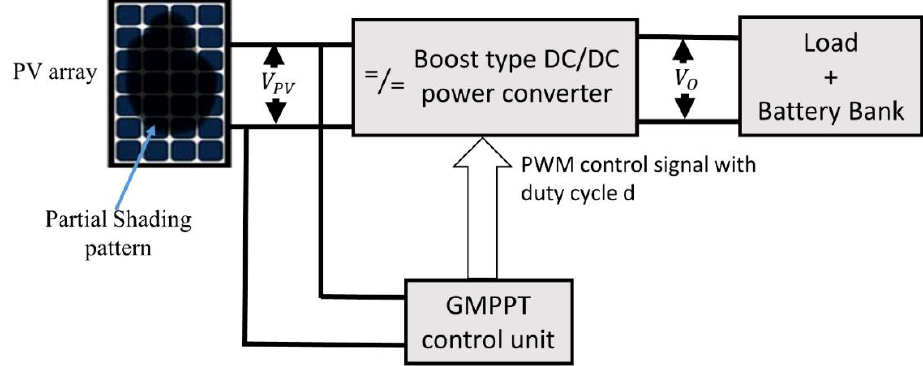
Figure 1. A photovoltaic (PV) system with maximum power point tracking (MPPT) control.